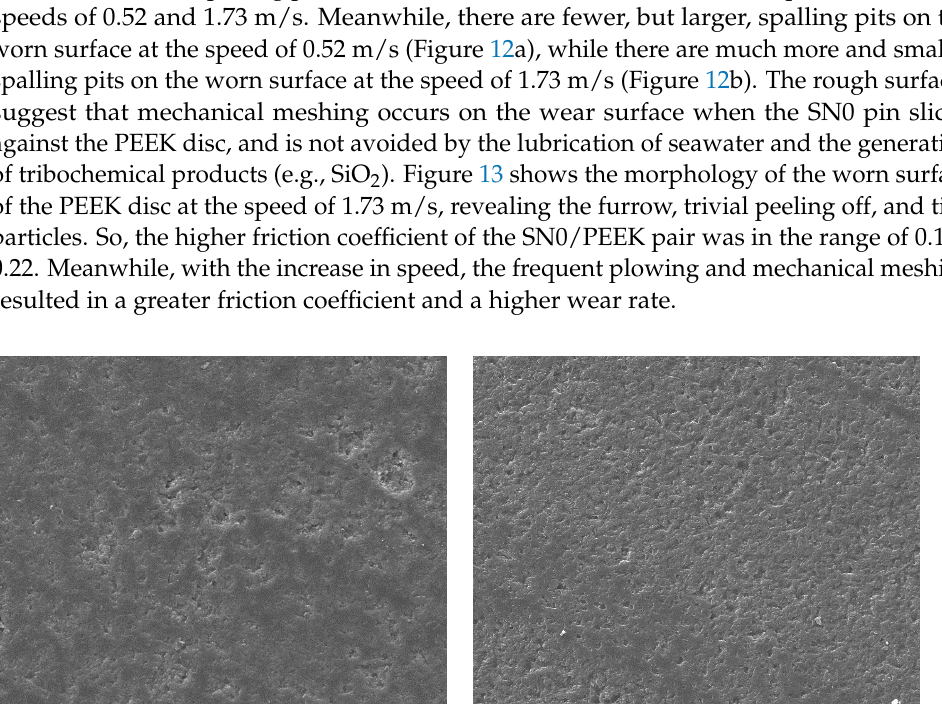
Figure 11. Worn surfaces of the SN5 pin against the PEEK disc in artificial seawater at the following different speeds: ( a ) 0.52 m/s; ( b ) 1.73 m/s.